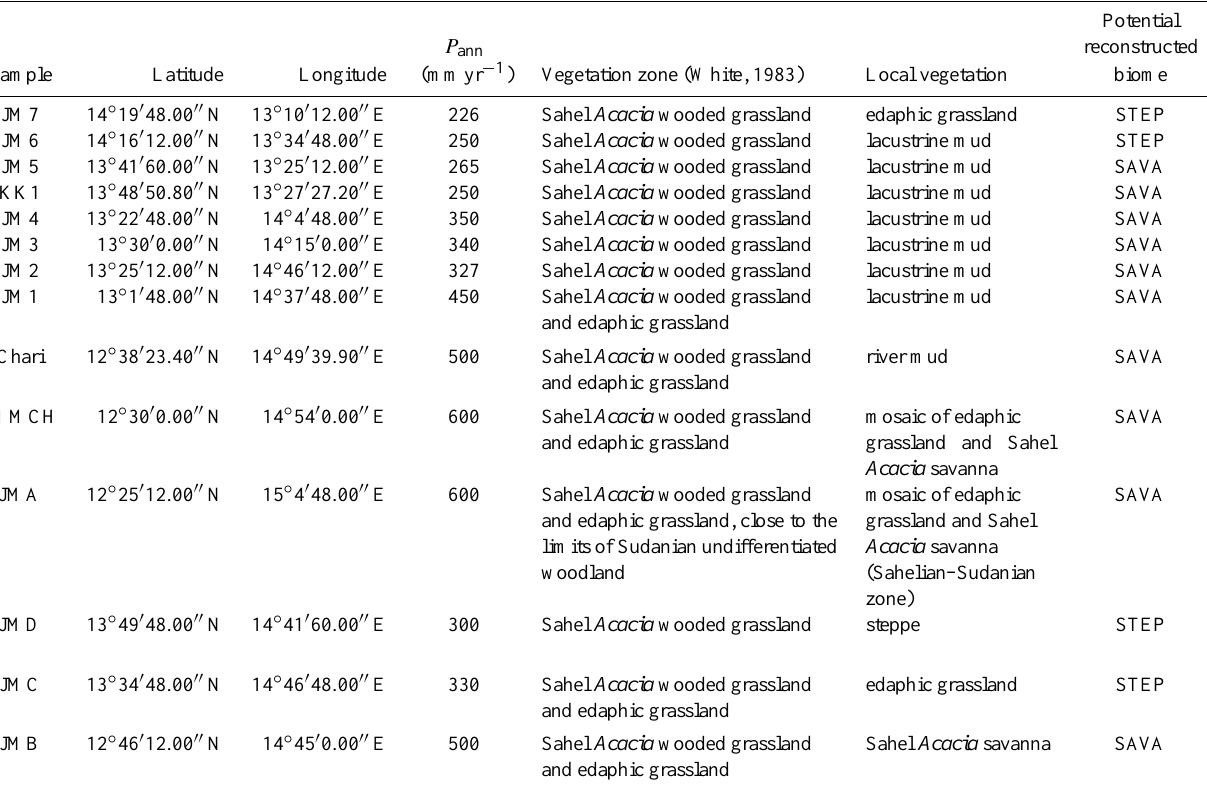
Table 2. Modern samples characterization: coordinates (latitude and longitude), P ann values (mmyr − 1 ), vegetation zone (White, 1983), local vegetation (Maley, 1972) and potential reconstructed biome (this